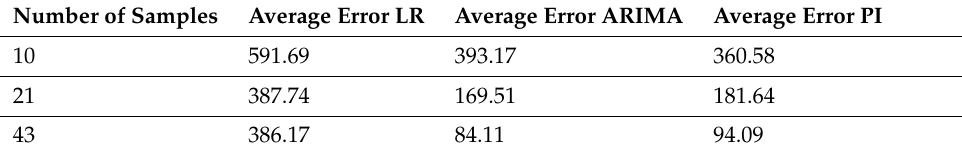
Table 15. Global errors E M c for different values of c